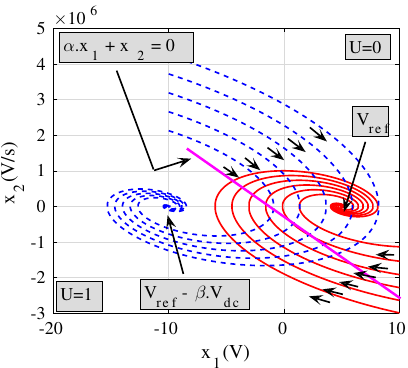
Figure 6. Phase portrait when U = 1 and U = 0. The state ( x 1 , x 2 ), belonging to either side of sliding line, is aimed at the line S = 0